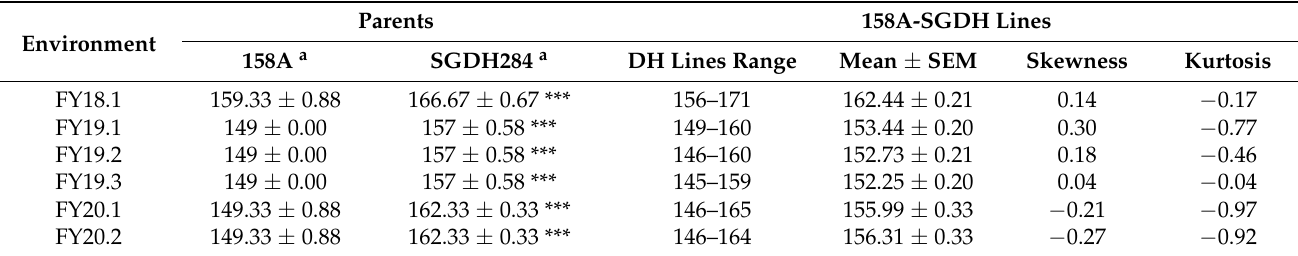
Table 1. Phenotypic variation of flowering time in the 158A-SGDH population and their parents.